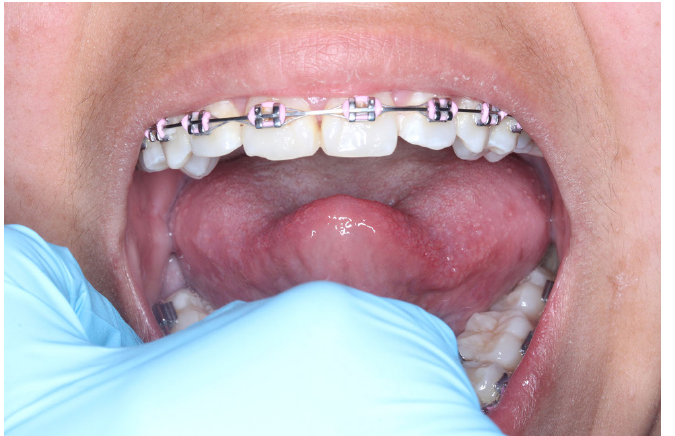
Figure 3. A clinical assessment of posterior tongue tie. The patients with posterior tongue tie showed cupping of the tongue during attempted elevation when the bottom of the tongue was being held down by the